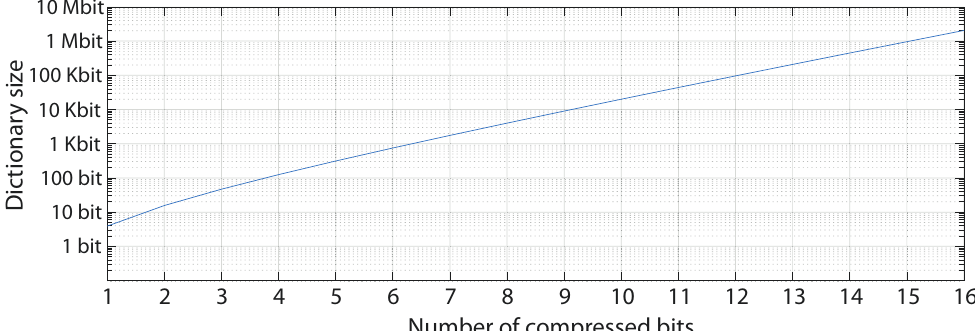
Figure 2. Dictionary size needed by the selected variation of the Huffman algorithm [47] for datasets of word lengths of 1 to 16